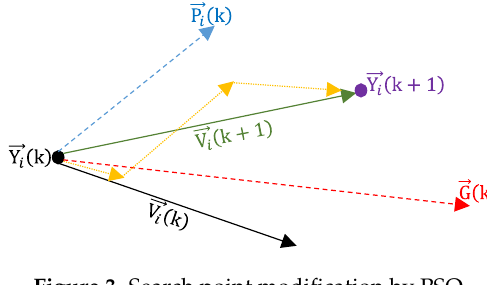
Figure 3. Search point modification by PSO.